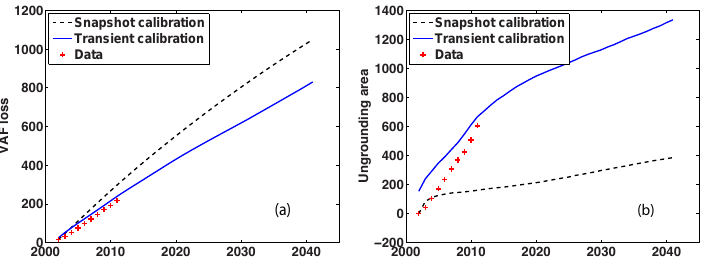
Figure 5. (a) Sea level contribution from the region and (b) total ungrounded area in domain through 2041 based on snapshot and transient calibrations (solid curves) and inferred from the DEM data, BEDMAP2, and Eq. (6) (red